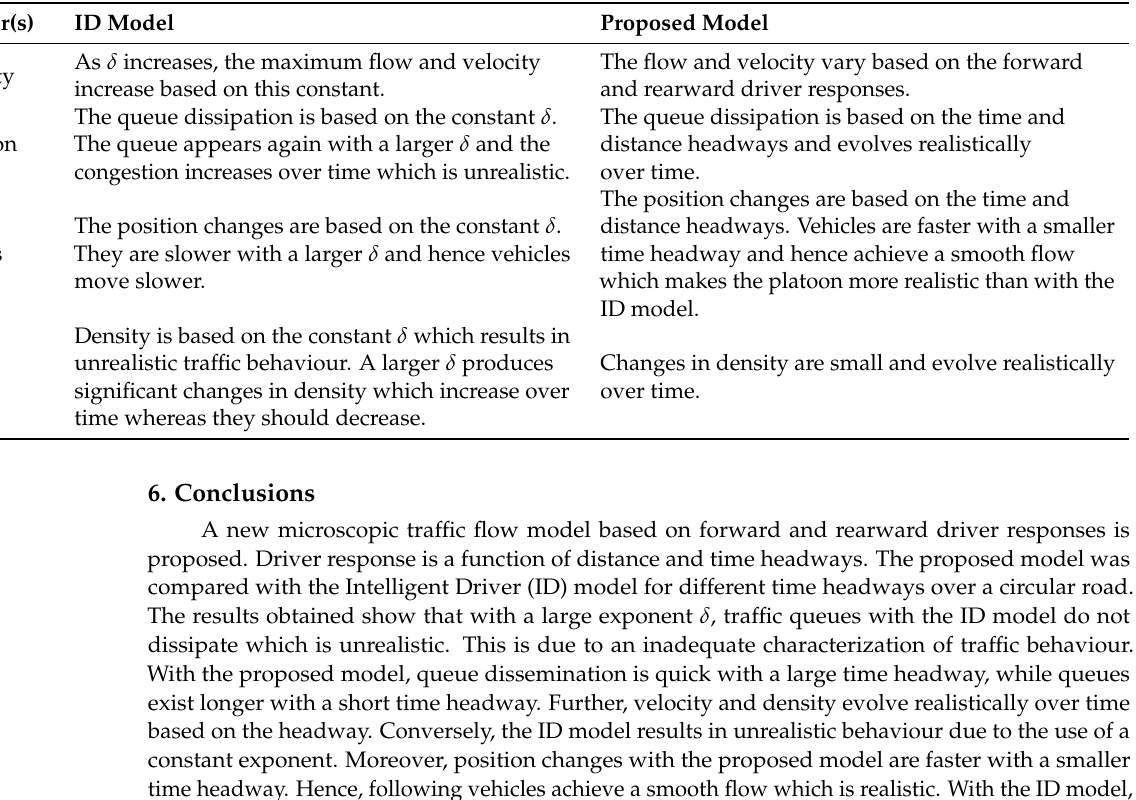
Table 7. Summary for the ID and proposed